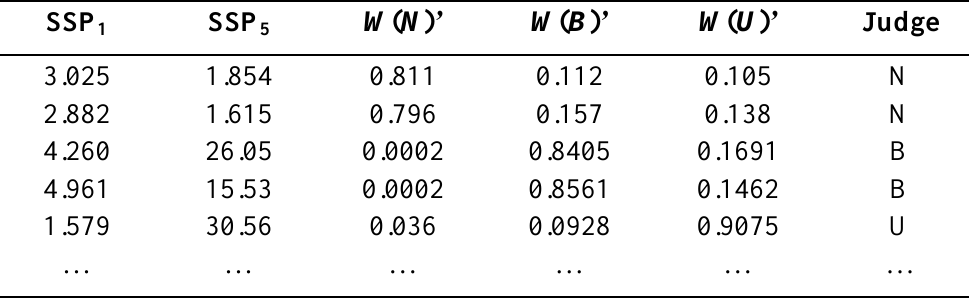
Table 9. Verification result of first